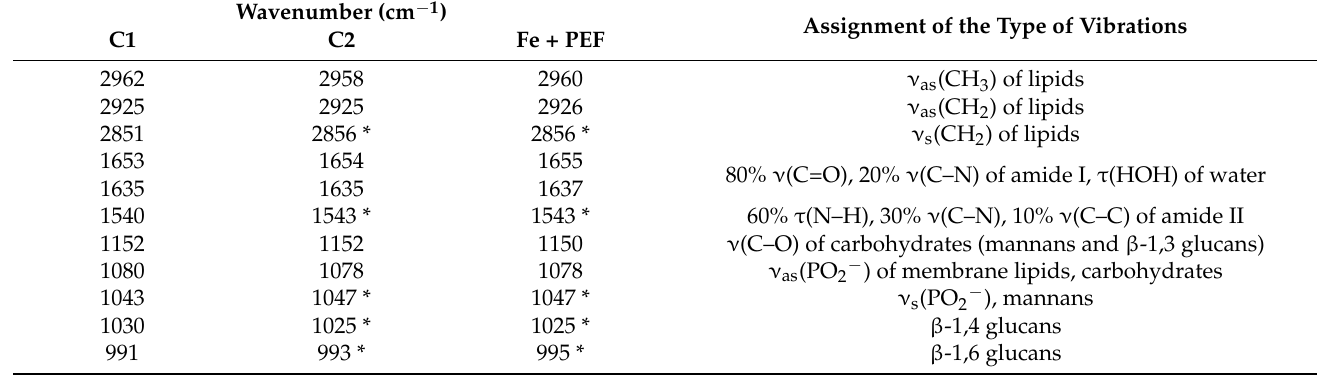
Table 1. The most important second derivative bands obtained in the spectra of all yeast samples, and the type of vibrations with assigned cellular